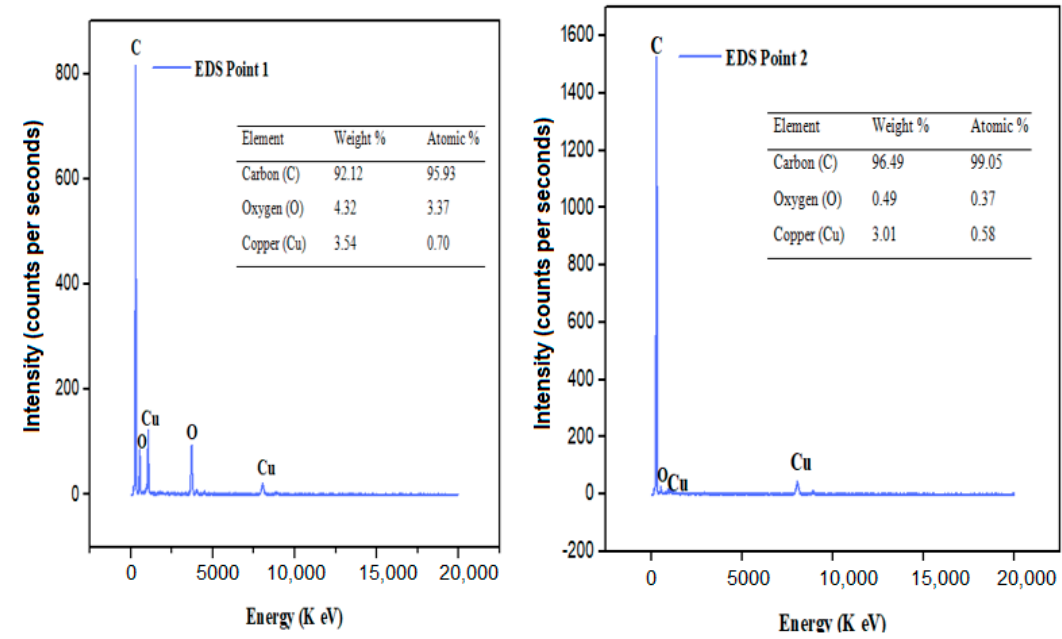
Figure 3. energy-dispersive spectroscopy (EDS) Spectra of carbon dots at point 1 and 2. Figure 3. Energy-dispersive spectroscopy (EDS) Spectra of carbon dots at point 1 and